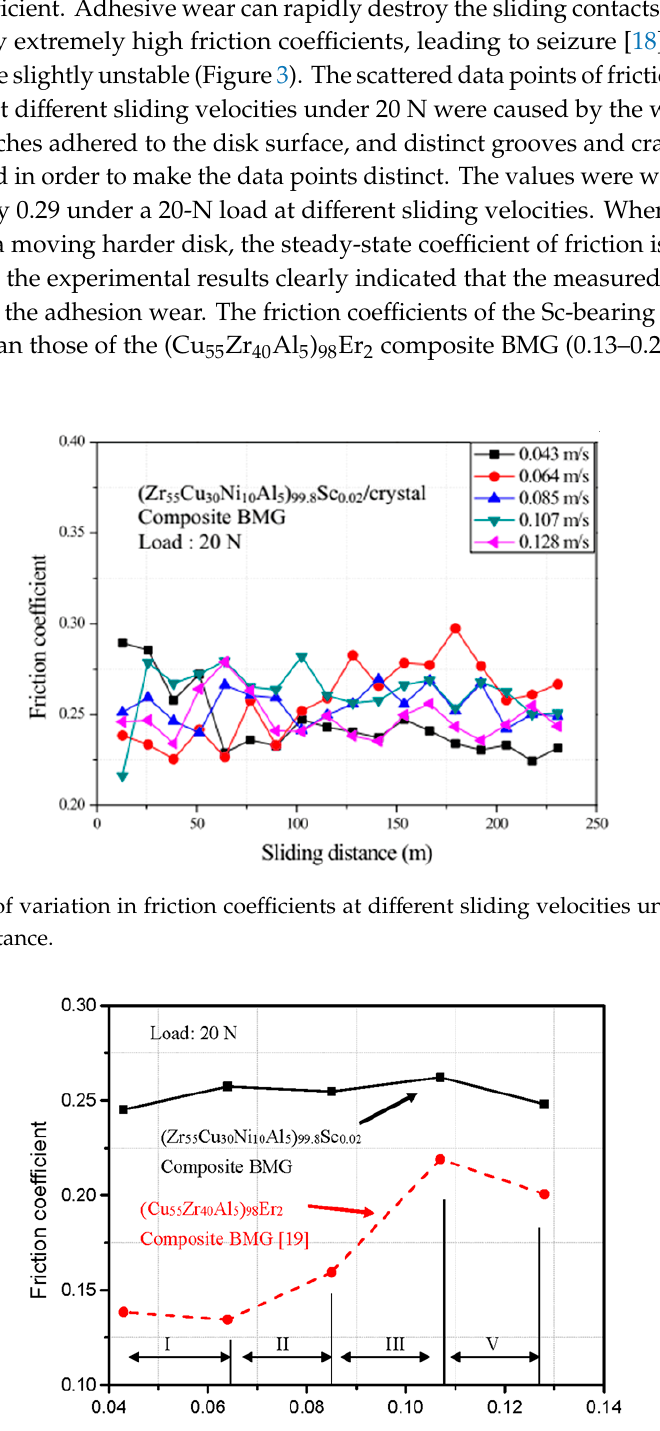
Figure 2. Comparison of X-ray diffraction patterns of the (Zr 55 Cu 30 Ni 10 Al 5 ) 99.8 Sc 0.02 composite BMG for the as-received condition and after wear testing under a 20 N load.